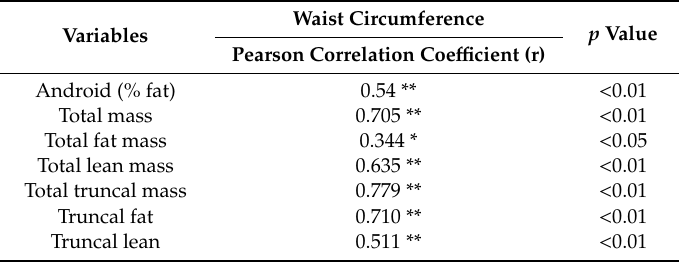
Table 6. Correlation between waist circumference and body composition variables in low GI and control diets in people with type 2